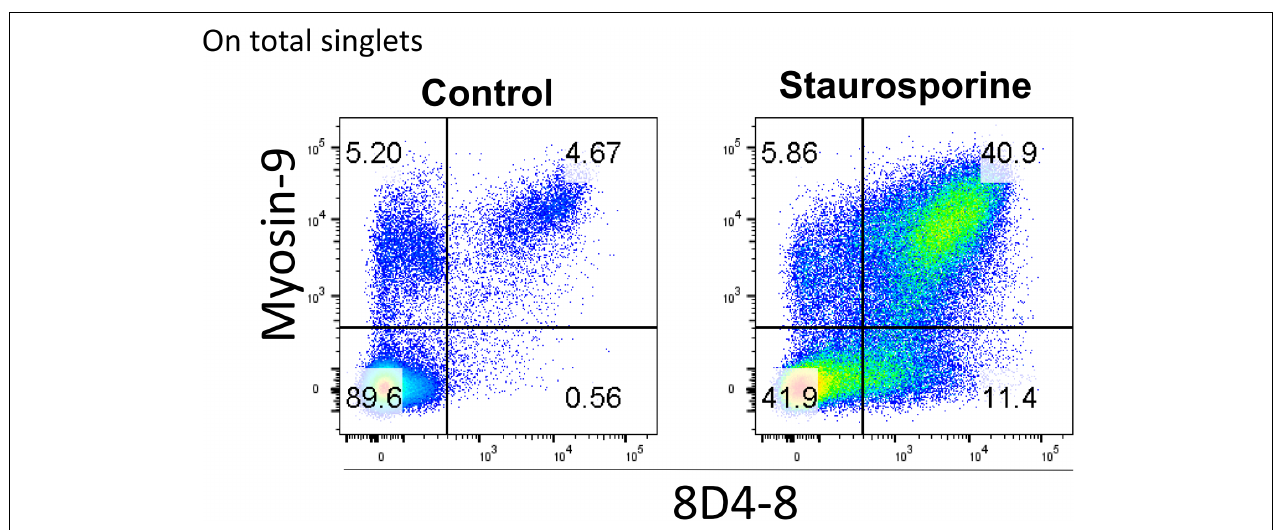
FIGURE 8 | Surface detection of 8D4-8 and myosin-9 colabels a population of increased size following staurosporine treatment. PBL were pregated to remove doublets (not shown). Cellular permeabilization is not required to detect 8D4-8 and myosin-9 among control or staurosporine-treated PBL. Results are representative of 3 experiments from 3